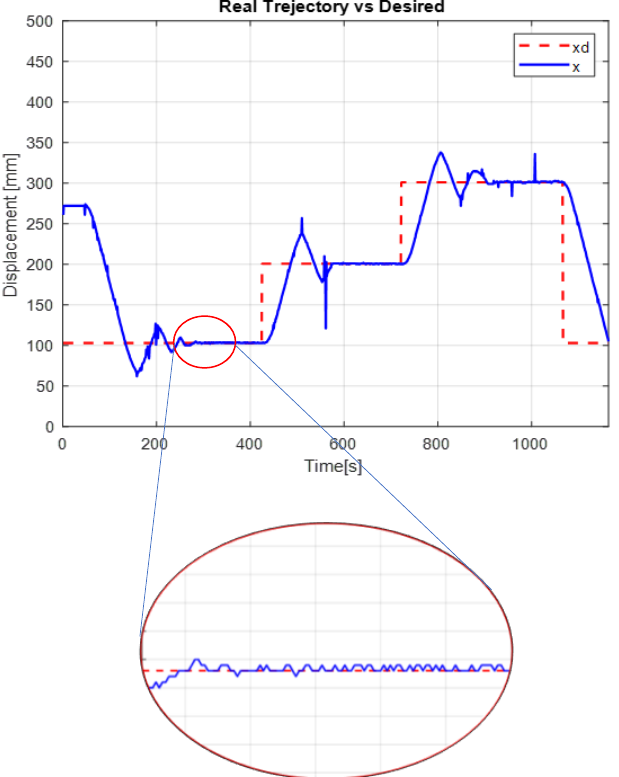
Figure 17. Real vs. desired trajectory with disturbance.